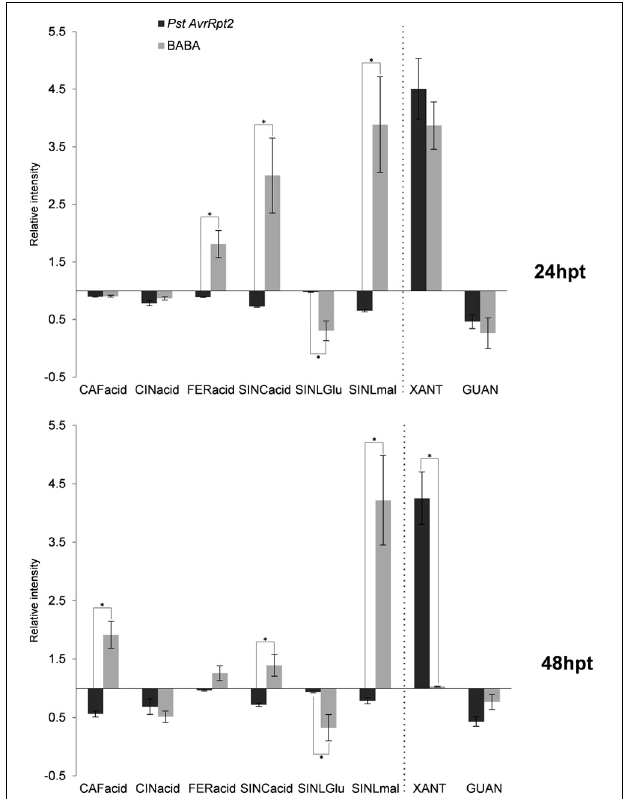
FIGURE 8 | Phenylpropanoid biosynthesis and purine catabolism compounds in priming. The experimental conditions and quantification were performed as explained above ( Figure 2 ). Asterisks represent statistically significant differences (Wilcoxon Mann–Whitney test, p < 0 . 05, n = 6). Data represent average of three independent